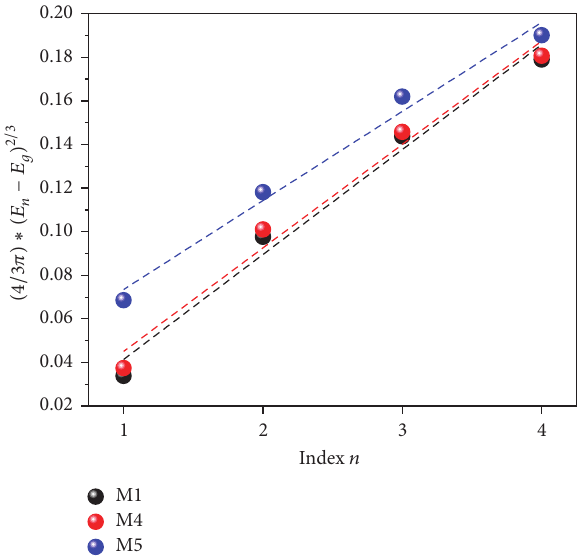
Figure 8: Linear fit in w-FKO analysis from PR spectra of M1, M4, and M5.